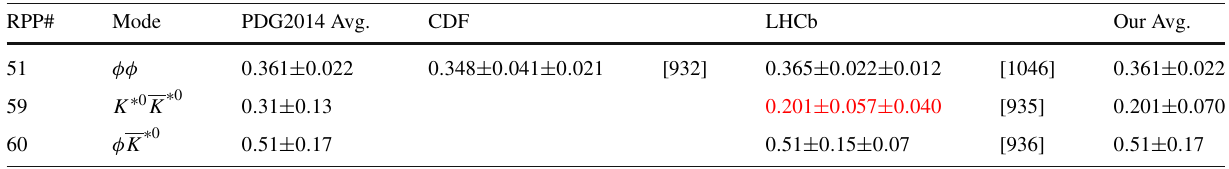
Table 253 Longitudinal polarization fraction f L for B 0 s decays. Where values are shown in red (blue), this indicates that they are new published (preliminary) results since PDG2014